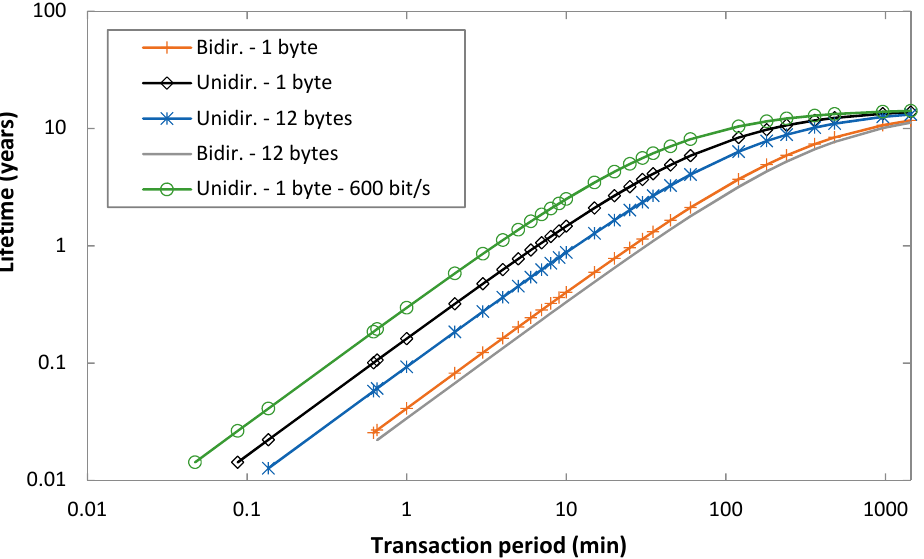
Figure 9. Device lifetime, for unidirectional and bidirectional transactions, as a function of T Period , and for uplink payload sizes of 1 byte and 12 bytes, for FLR = 0.